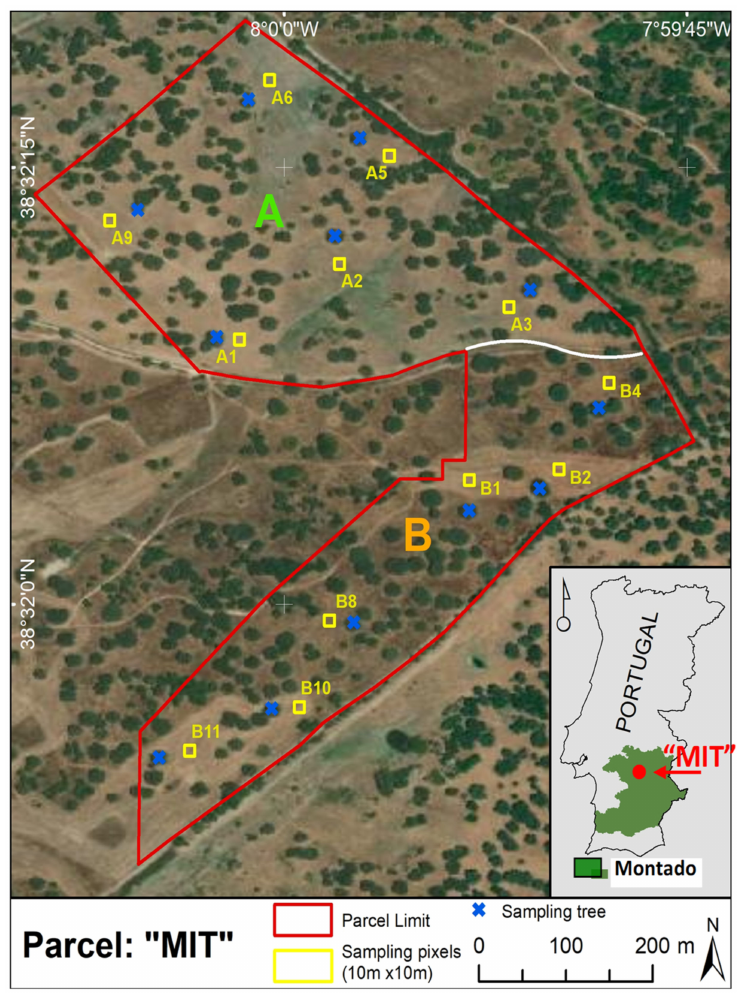
Figure 2. Approximate sampling locations in field A and field B: areas without trees (“sampling pixels”; outside tree canopy, OTC) and areas under tree canopy (“sampling tree”;